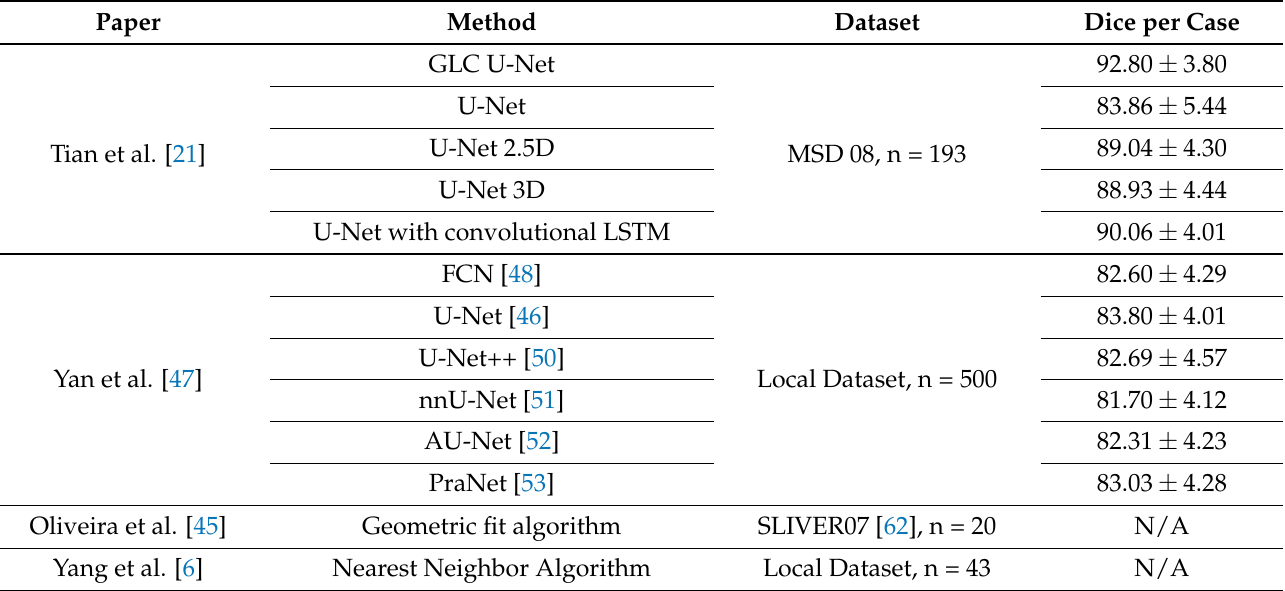
Table 7. Literature overview for liver segments’ classification. Quantitative results are not available for [6,45], since they only provided visual assessment of the segments’